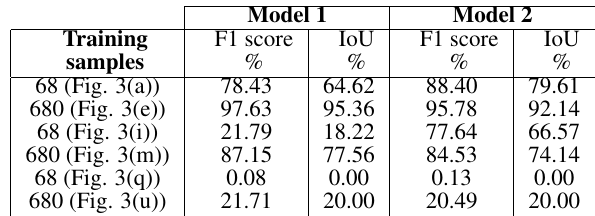
Table 1. Average IoU and F1 score values for 4 datasets of training and evaluated on a 95-image test dataset using model 1 and model 2.